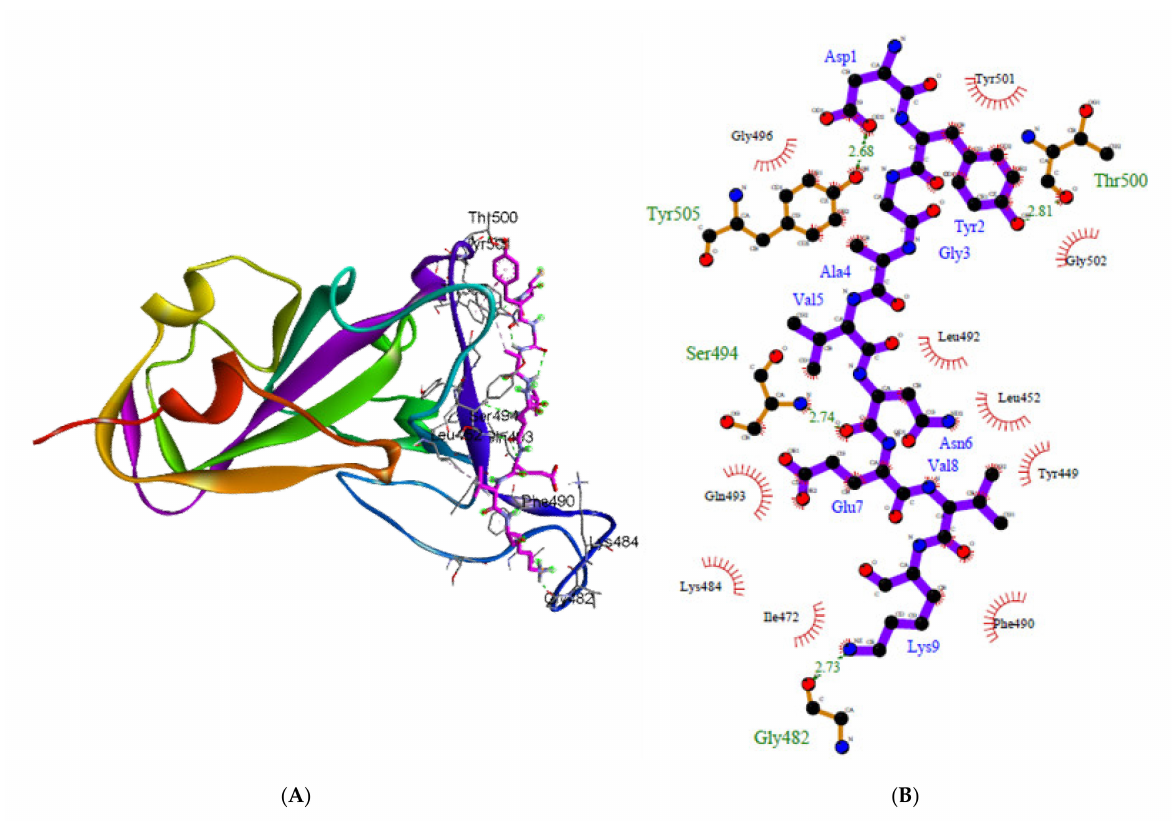
Figure 4. Sketch diagram depicting the 3D ( A ) and 2D ( B ) interaction between bromelain-derived peptide and RBD BR by LigPlot+. RBD BR contains the mutations K417T, E484, and